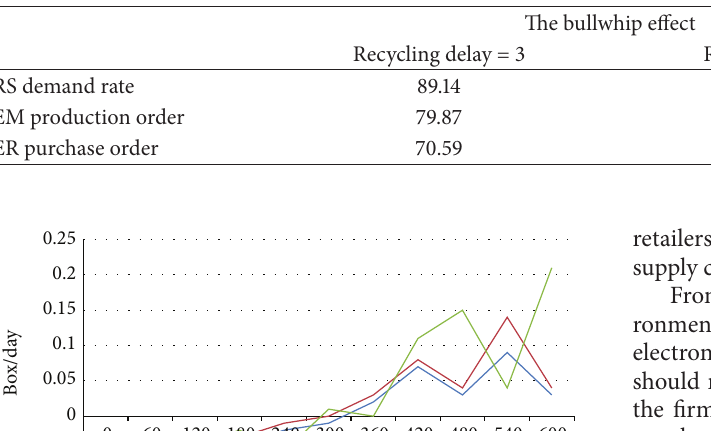
Table 3: The bullwhip effect in all members with different recycling delay.